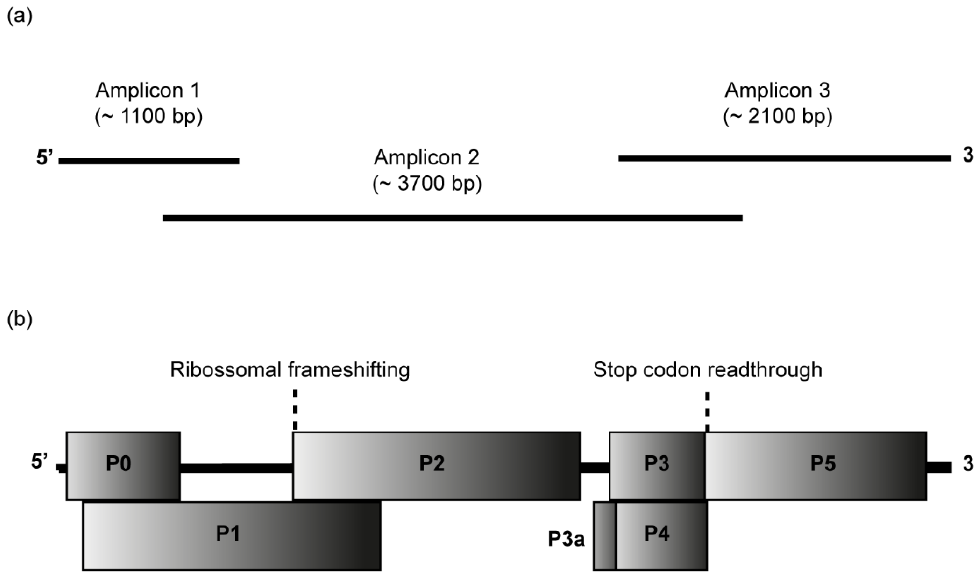
Figure 2a. Passion fruit plants from Seabra (samples 558 and 564), Morro do Chap é u (sample 799), and Lenç ó is (samples 724, 726, and 729) were selected for full-length CABYV genome sequencing.